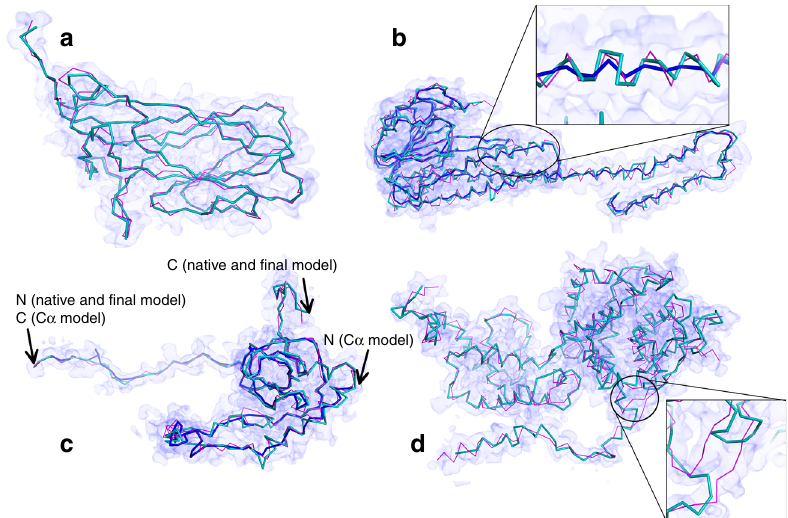
Fig. 4 Examples of models generated by MAINMAST for experimental EM maps. The models were ranked fi rst by the MDFF ’ s score. Structures in turquoise are computed by MAINMAST and structures in magenta are the native structure. a capsid protein of porcine circovirus at 2.9 Å resolution (EMD-6555). MAINMAST model: 2.4 Å RMSD. Coverage and precision were both 0.88. Coverage and precision are de fi ned as the fraction of C α atoms in the native and the model, respectively, which are closer than 2.0 Å to any C α atoms of the counterpart. Rosetta models have RMSDs of 31.6 and 30.4 Å with the default and a 0.8 consensus setting, respectively. Cov: 0.36, Prec: 0.36. b magnesium channel CorA at 3.8 Å resolution (EMD-6551). MAINMAST model (turquoise), RMSD: 4.4 Å, Cov: 0.91, Prec. 0.92. blue, the main-chain model prior to PULCHRA/MDFF re fi nement, RMSD: 10.7 Å, Cov: 0.81, Prec: 0.84. Rosetta models, 20.4/12.3 Å RMSD, Cov: 0.75/0.79, and Prec: 0.75/0.79 with the default/a 0.8 consensus setting. c eL6 protein from yeast 60S ribosomal subunit, at 2.9 Å resolution (EMD-6478). MAINMAST model, RMSD: 2.6 Å, Cov: 0.90, Prec: 0.90; blue, the main-chain model prior to PULCHRA/MDFF, RMSD:40.9 Å, Cov: 0.73, Prec: 0.74. This large RMSD is due to the failure of scoring a model with the correct sequence orientation by the threading score. However, a model with the correct sequence orientation was selected by MDFF after re fi nement. Rosetta models, 25.6/42.0 Å RMSD, Cov: 0.63/0.42, and Prec: 0.63/0.42 with the default/a 0.8 consensus settings. d helical Measles virus nucleocapsid protein at a 4.3 Å resolution (EMD- 2867). MAINMAST model, RMSD: 9.3 Å, Cov: 0.68, Prec: 0.68; Rosetta models, RMSD: 21.3/10.6 Å, Cov: 0.68/0.72, Prec: 0.68/0.72 with the default/a